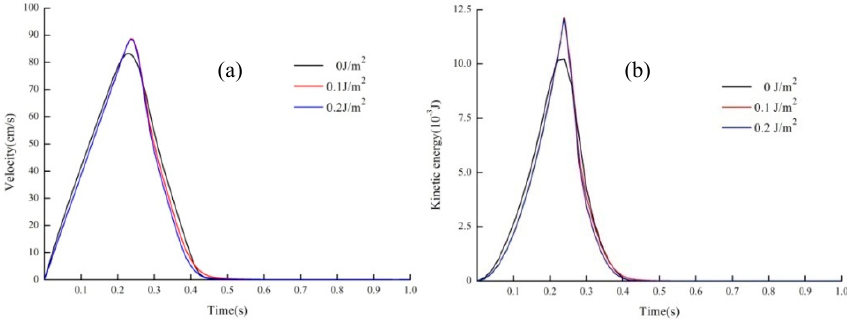
Figure 17. Theoverallvelocity and kinetic energy of the wet soil granular flow, ( a ) Overall sliding velocity;( b )Kinetic energy.